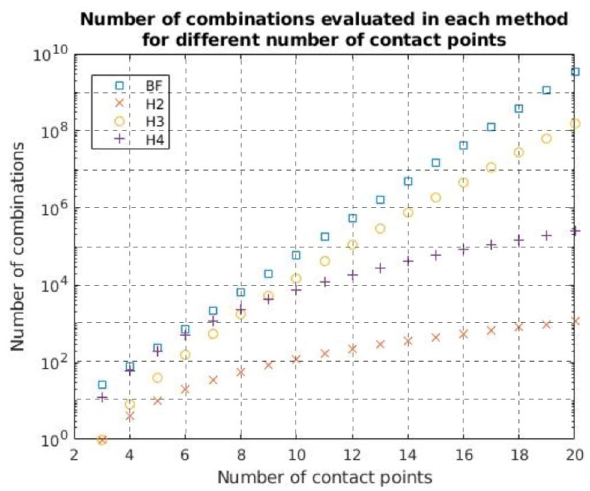
Fig. 4 Number of combinations evaluated in each method given the number of contact points, computed from NOC BF , NOC H 2 , NOC NOC H H 3 and